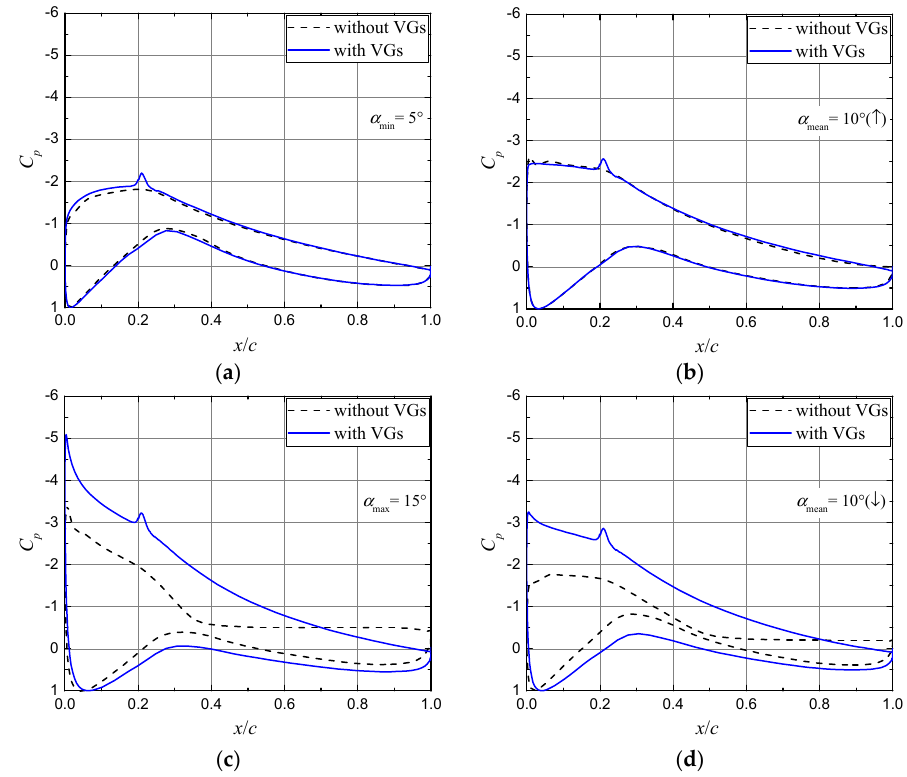
Figure 11. Unsteady pressure distributions at the typical AOA over one pitch-oscillation cycle at k = 0.055. ( a ) α = 5 ° (min.); ( b ) α = 10 ° (mean value during the upstroke); ( c ) α = 15 ° (max.); ( d ) α = 10 ° (mean value during the downstroke).